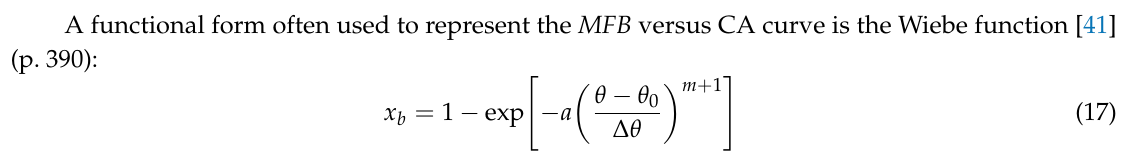
Figure 8. P – V diagram of the air-standard cycle and experimental